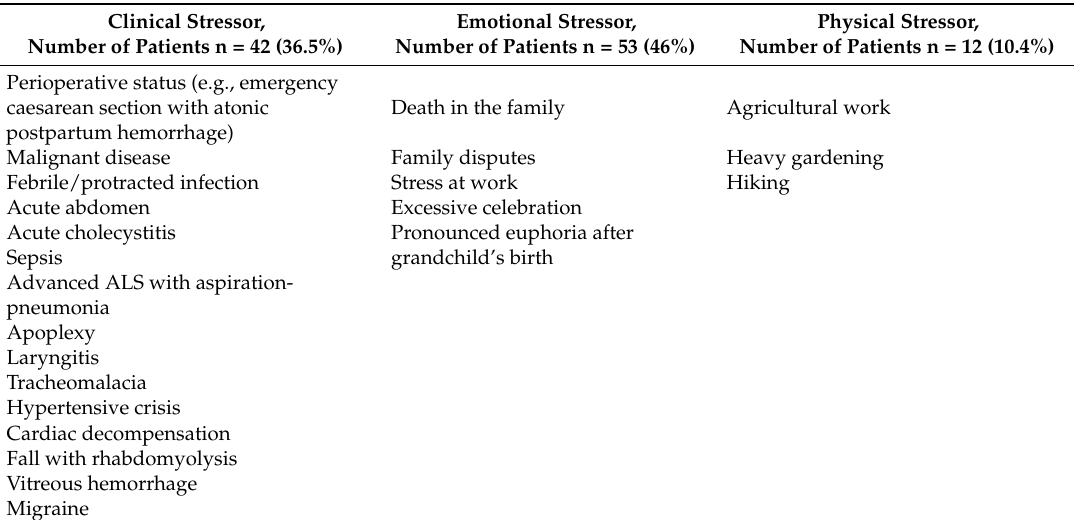
Table 2. Clinical, emotional, and physical triggering factors of TTC in patients (total number, n = 115; multicenter registered analysis)—ALS: Amyotrophic Lateral Sclerosis.